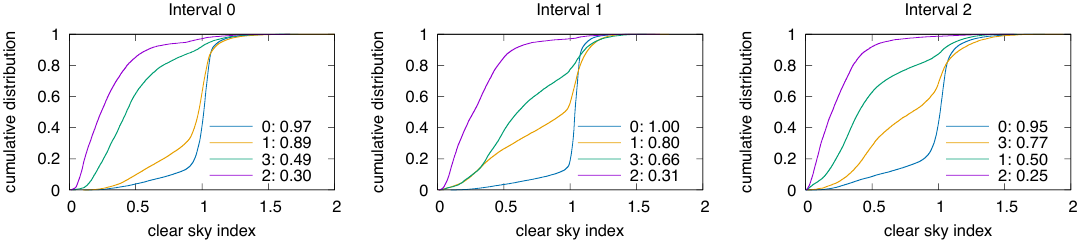
Figure 6. Distributions of the clear sky index for Golden with 4 day types and 3 day